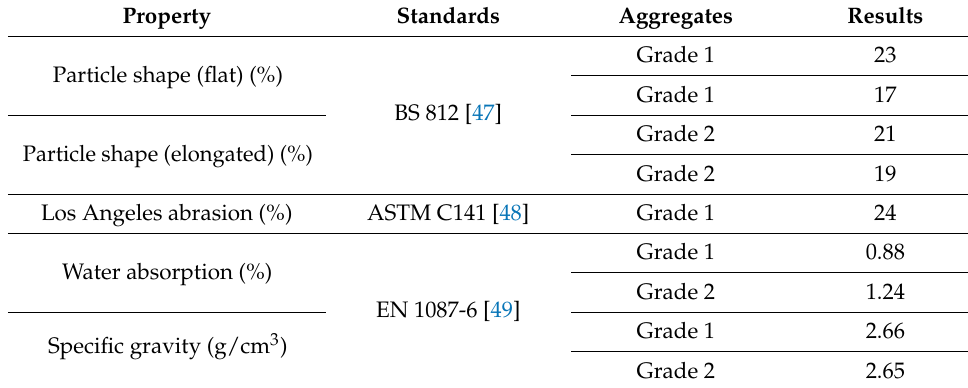
Figure 3. Crumb rubber SEM micrographs for: ( a ) Ambient crumb rubber; ( b ) Cryogenic crumb rubber. Table 4. Results of coarse aggregate characterization tests.